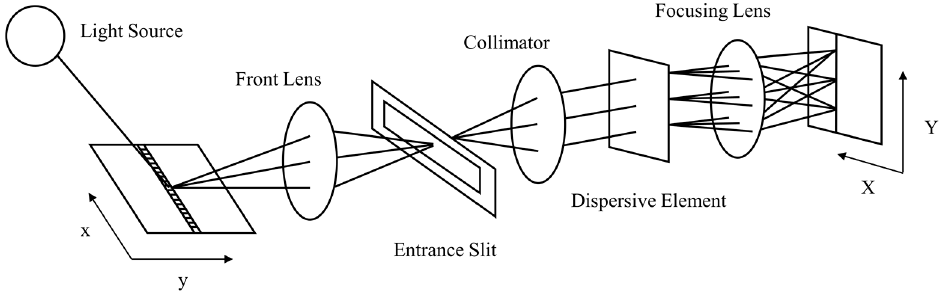
Figure 1. The workflow of push-broom hyperspectral imagers. (x refers to the cross-track direction, and y refers to the along-track direction; X is the spatial dimension in detector, and Y is the spectral